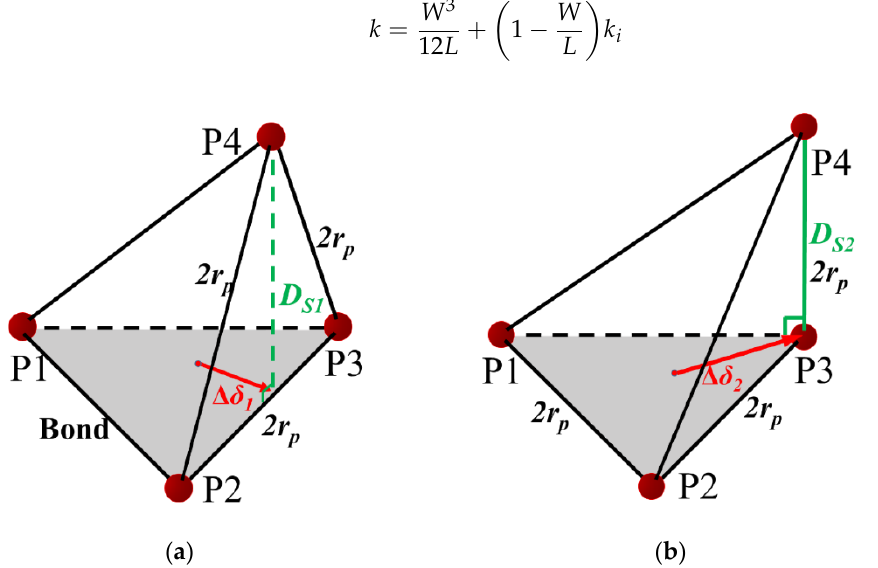
Figure 12. Illustration of the relation between crack width and shear displacement. Shear forms shown in ( a ) and ( b ) are corresponded to Equations (6) and (7) respectively.